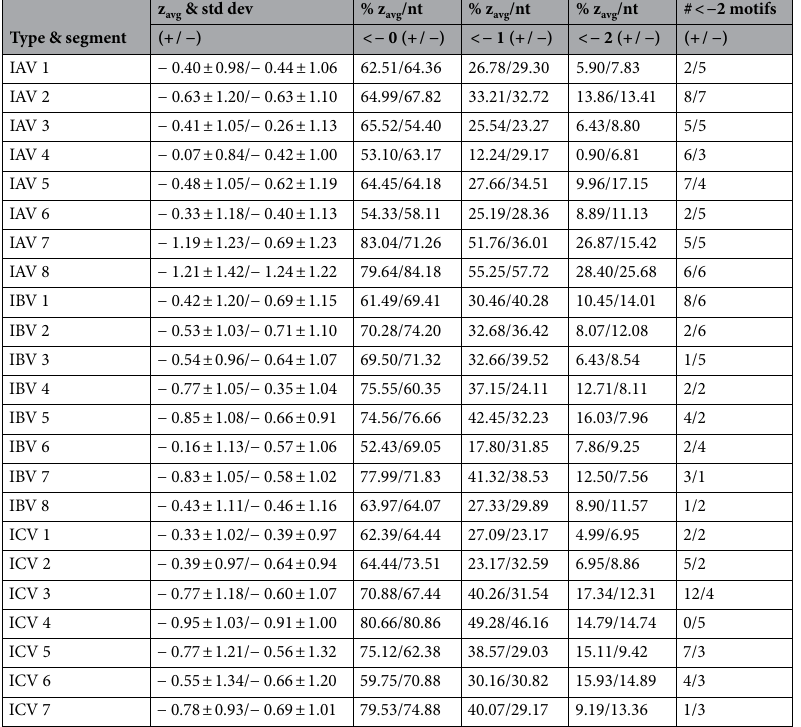
Table 1. Average ScanFold metrics and extracted motifs for each strand. “% z avg /nt” is the percentage of nucleotides that had z avg scores below the given threshold. “# < −2 Motifs” is the number of extracted motifs for each strand below the −2 z− score threshold, totaling 185.